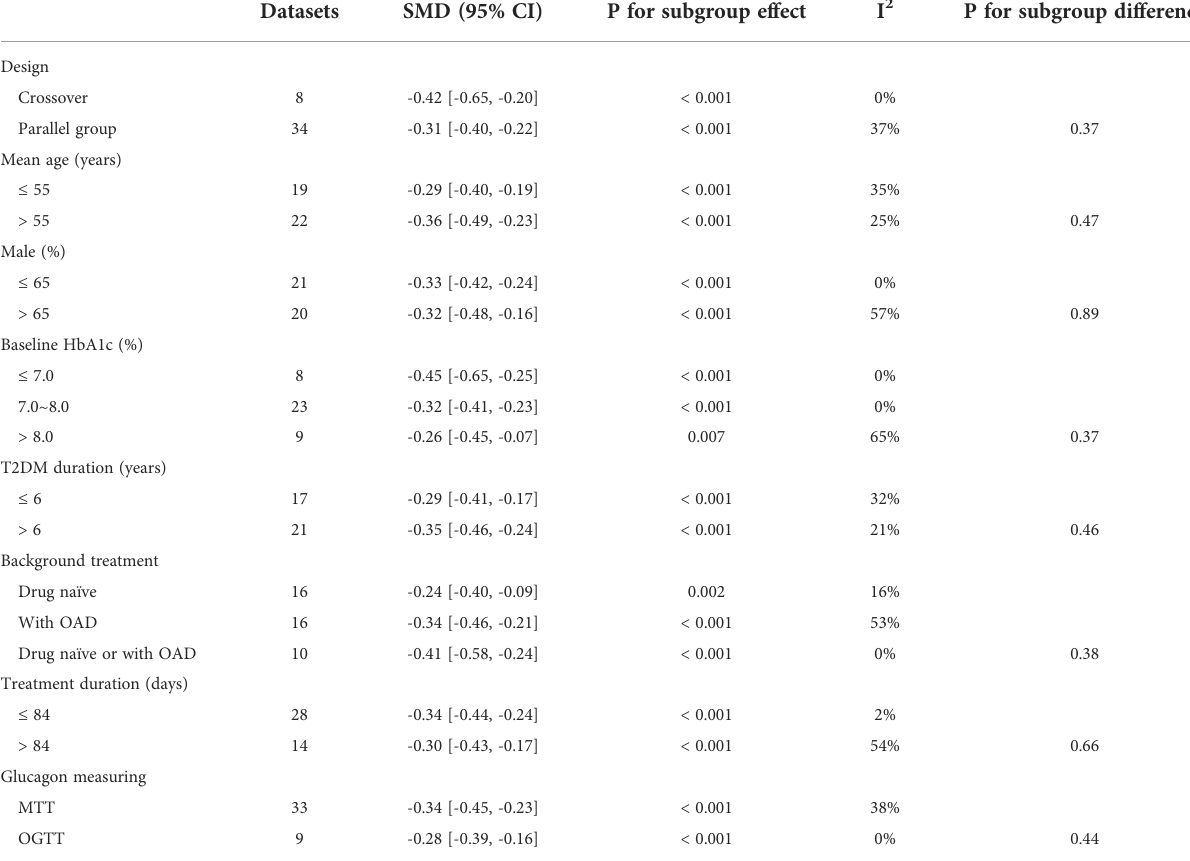
TABLE 3 Subgroup analysis for comparing DPP4 inhibitors with placebo treatment on circulating